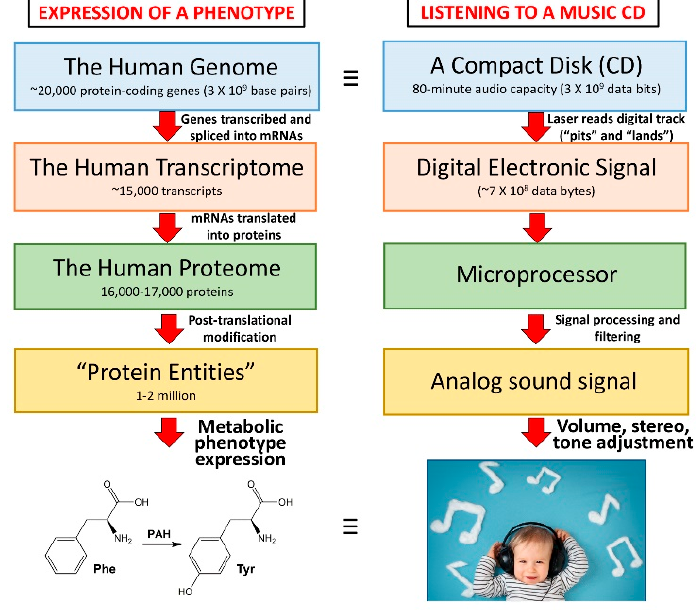
Figure 1. The flow of genetic information vs. digital music data flow.